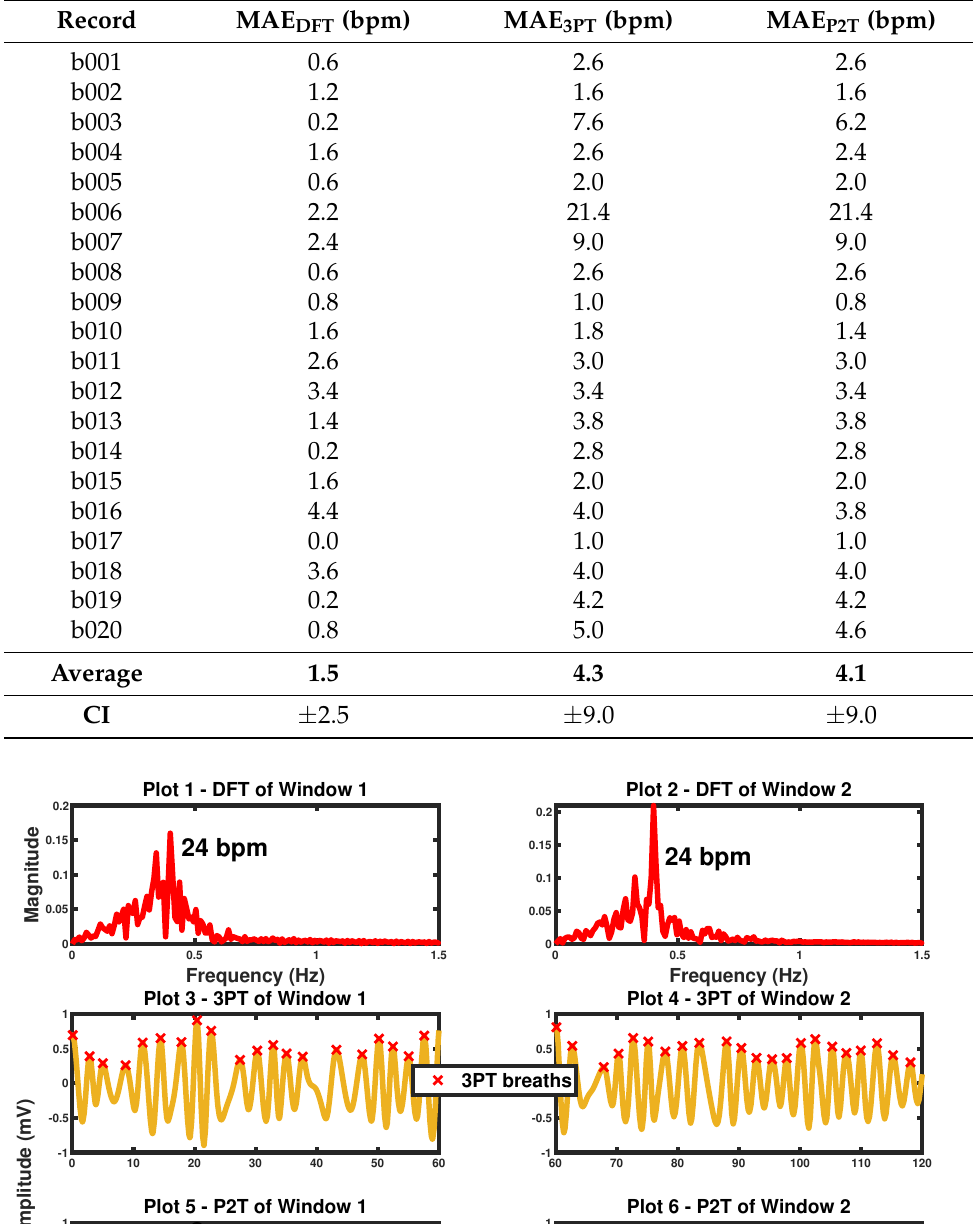
Table 6. EMDDR performance.